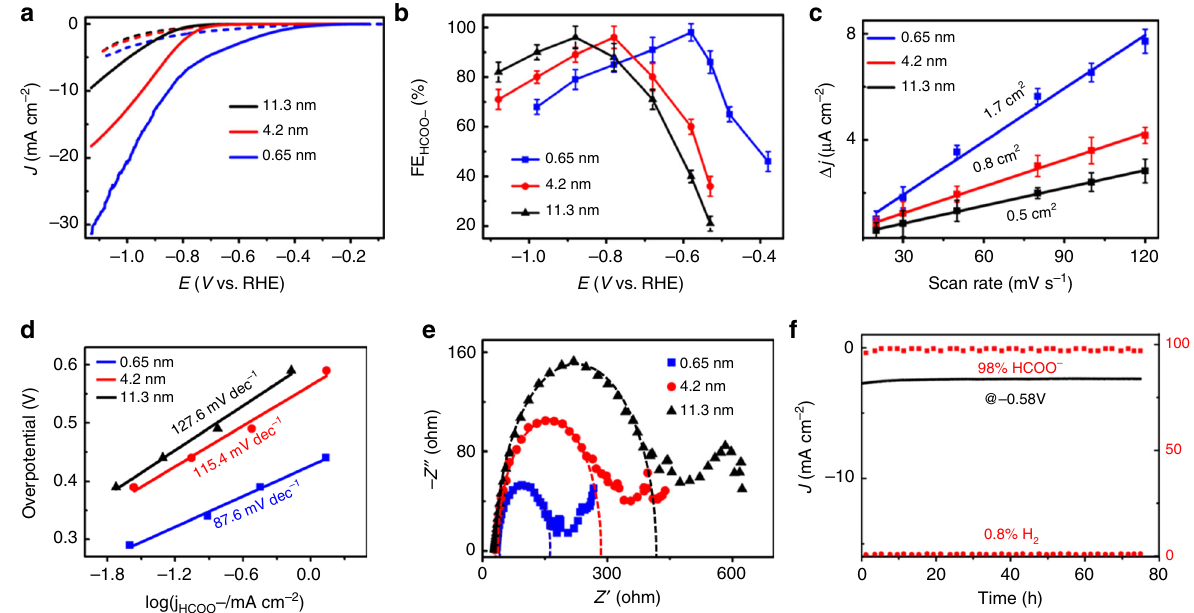
Fig. 3 Electroreduction of CO 2 to formic acid on BiNSs. a pH-corrected linear sweep voltammetric curves (LSV) in the CO 2 saturated (solid line pH 7.2) and N 2 saturated (dash line pH 8.8) 0.5 M KHCO 3 aqueous solution with the same Bi loading of 0.39 mg/cm 2 on glassy carbon electrode. b Comparison of Faradaic ef fi ciencies for formate at each applied potential for BiNSs with different thicknesses. c Charging current density differences Δ j plotted against scan rates on BiNSs with different thickness for the calculation of ECSA. d Tafel plots of the partial HCOO − current density for BiNSs with different thicknesses. e Nyquist plots for BiNSs with different thicknesses. The dotted curves are the fi ttings. f Long-term stability of Bismuthene nanosheets (0.65 nm) at a potential of − 0.58 V and the corresponding FEs for HCOO − and H 2 . All the error bars in ( b , c ) represent the standard error of the